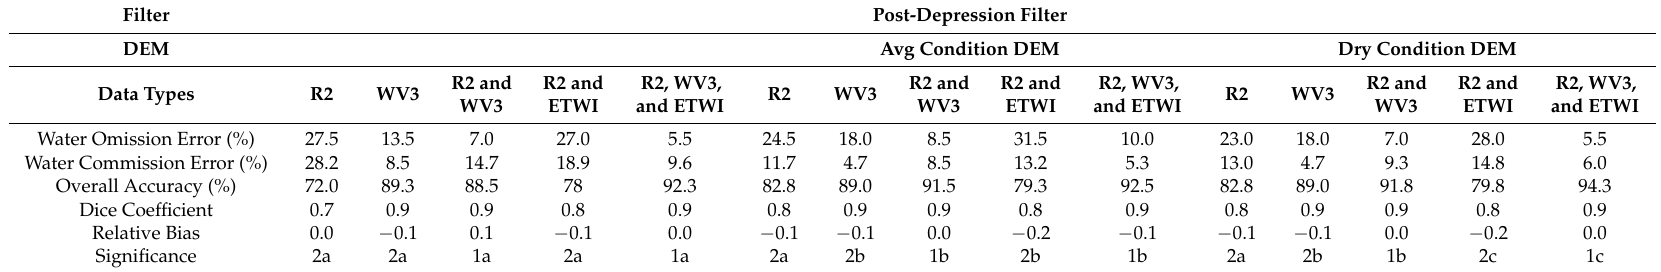
Table 6. Comparison of mapping accuracy using single versus multiple sources of imagery. Mixed models were performed using random forest and included Radarsat-2 (R2) imagery (2 April 2015), Worldview-3 (WV3) imagery (6 April 2015), and the enhanced topographic wetness index (ETWI). Models were modified using a depression filter derived using a lidar digital elevation mode (DEM) collected in dry or average wetness conditions. All validation data points occurred within a forested cover class. Different numbers indicate a significant difference between models within a filter type, while different letters indicate a significant difference for a given model after applying a filter. Significance was determined using McNemar’s chi-squared test with continuity correction. Different letters indicate significant